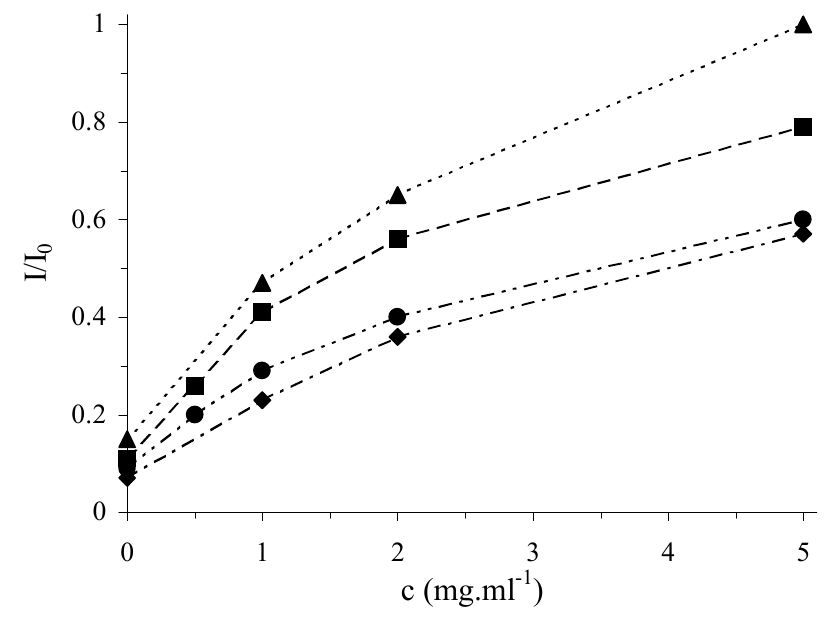
Figure 3. Antioxidative effect of rosmarinic acid ( (cid:86) ) and caffeic acid ( (cid:132) ) in cleavage mixture on the relative marker signal at the DNA/SPE. Incubation of the sensor in 2x10 -4 M FeSO 4x10 -4 M EDTA, 9x10 -3 M H O in 10 mM phosphate buffer pH 7.0 with10 % of methanol at 2 2 the electrode potential of –0.5 V for 5 min. Other conditions as in Figure 1.